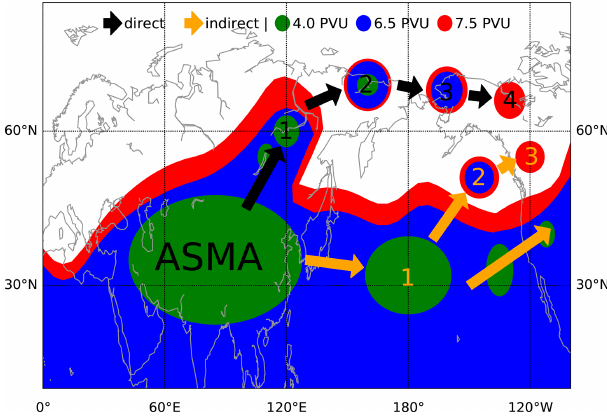
Figure 1. Schematic of the two idealized transport path- ways from the ASMA into the stratosphere and the role of low PV cutoffs on 380K for each of the pathways. Green areas mark cutoffs with PV ≤ 4.0PVU, and blue marks areas with 4.0PVU < PV < 6.5PVU. Red shows areas with 6.5PVU < PV < 7.5PVU. The black arrows indicate the direct transport pathway, and the orange arrows indicate the indirect path- way. Numbers denote the temporal evolution of the cutoff